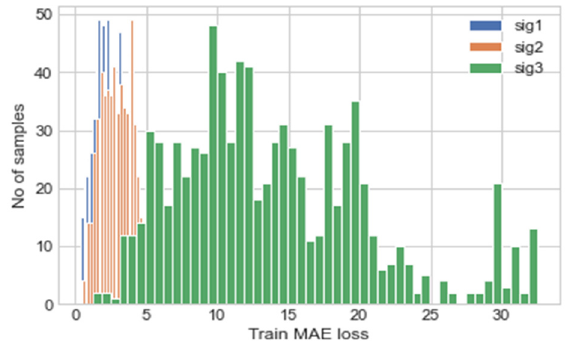
Figure 9. Histogram depicting MAE of each prediction for each input/output channel.